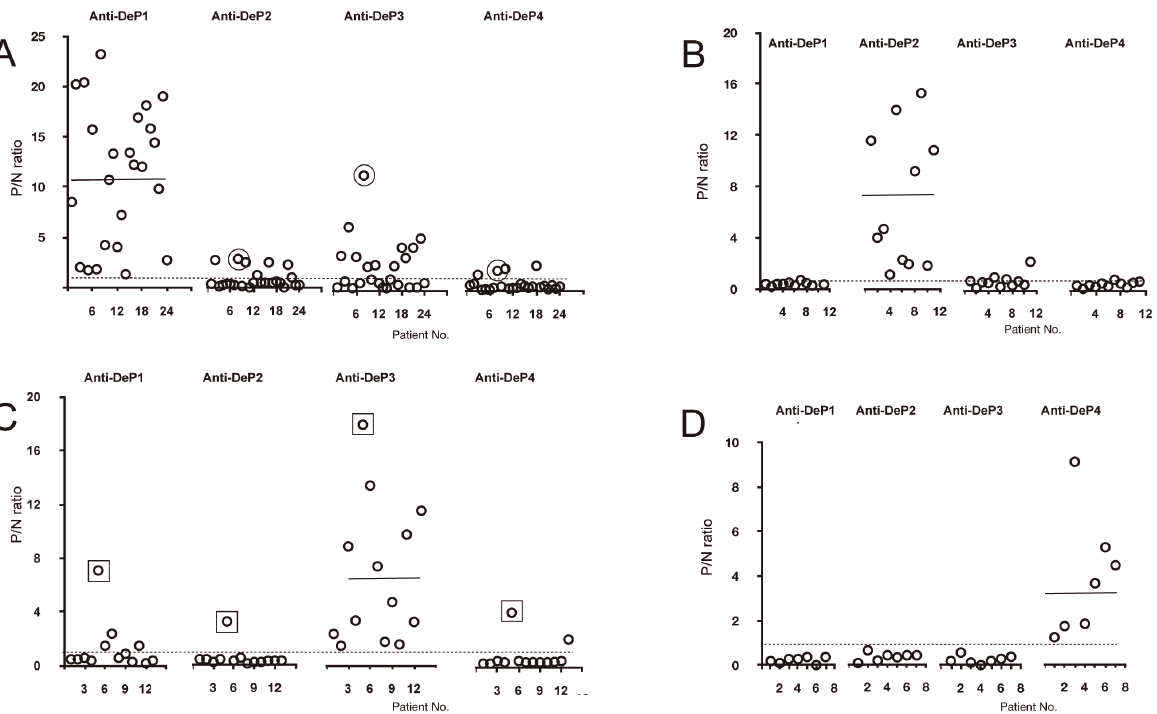
Figure 2. Antibody reactions (P/N ratios) to all four DENV DeP antigens using the ICB ELISA without competition. A : Sera of 24 patients with DENV-1 infection. B : sera of 11 patients with DENV-2 infection. C : sera of 13 patients with DENV-3 infection. D : sera of 7 patients with DENV-4 infection. DENV serotype had been confirmed by RT-PCR. Dotted lines represent cut-off values. Sample of patient 8 in A and of patient 5 in C with strong cross-reactivity are marked with circle and square, respectively. P/N values were calculated using OD/cut-off values.